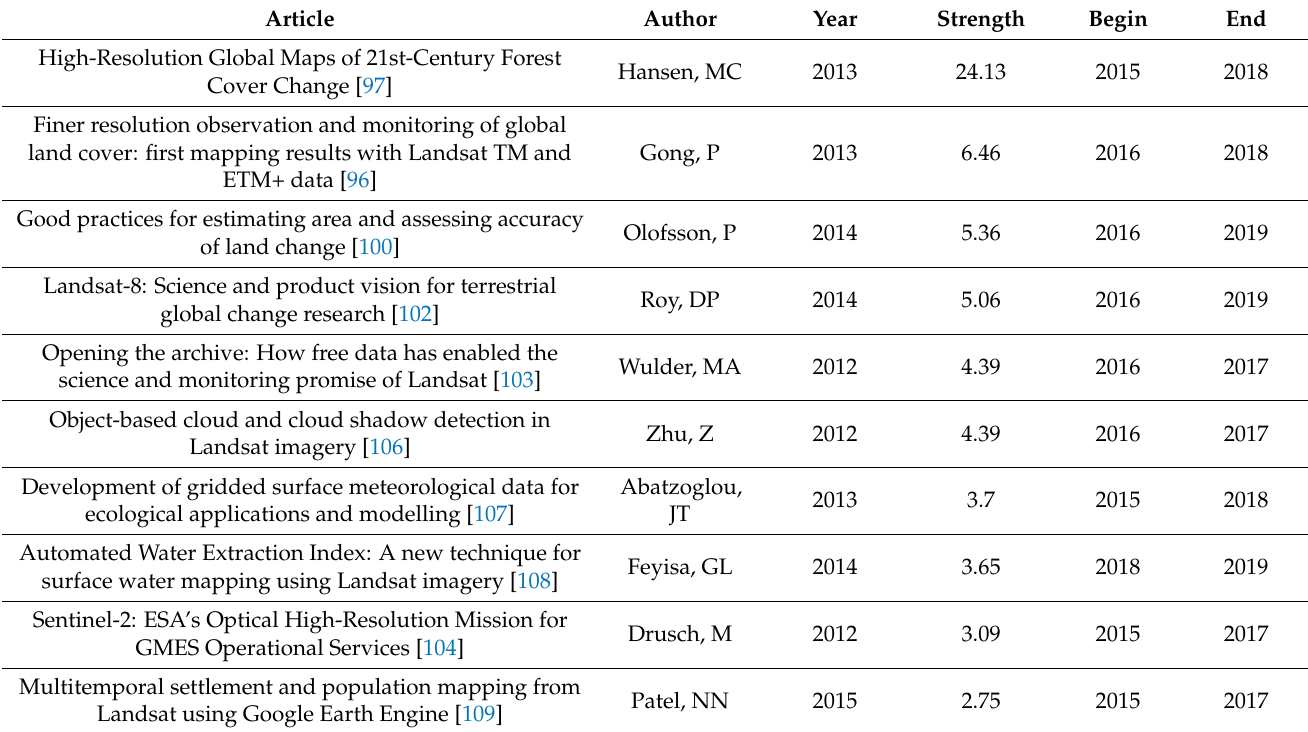
Table 2. GEE papers with the strongest citation